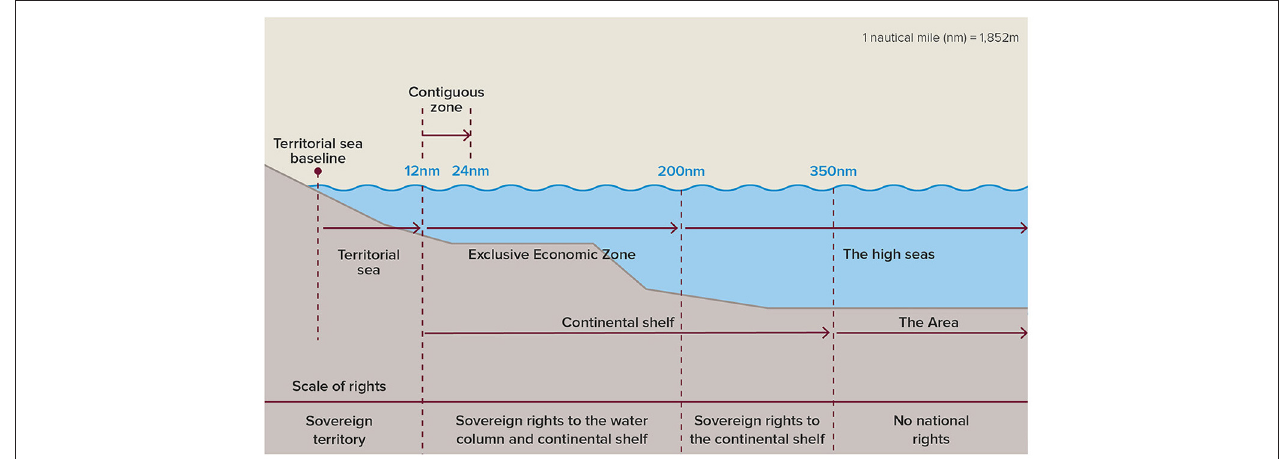
FIGURE 3 | A schematic showing jurisdictional zones from a nation’s coast. Courtesy: The Royal Society,